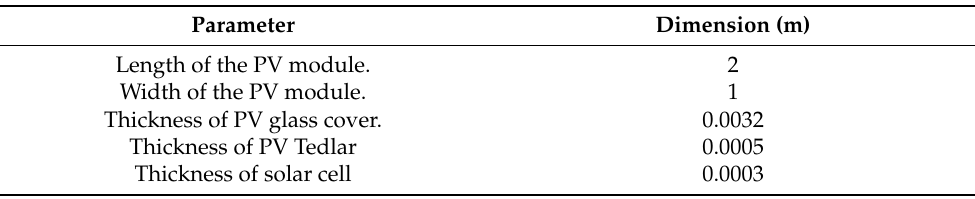
Table 1. Cont . Parameter Dimension (m) Length of the PV module. 2 Width of the PV module. Thickness of PV glass cover.